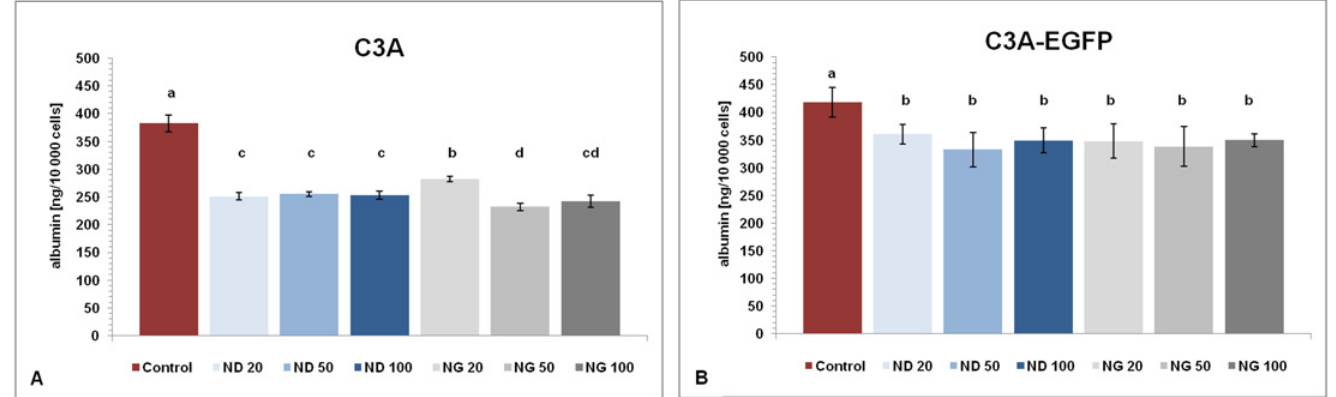
Fig 6. Human serum albumin concentration in culture medium. Albumin secreted by the C3A and C3A-EGFP cells treated for 24 h with the culture medium containing nanoparticles at different concentrations measured by ELISA test: diamond 20 μ g/mL (ND 20), 50 μ g/mL (ND 50) and 100 μ g/mL (ND 100), and graphite 20 μ g/mL (NG 20), 50 μ g/mL (NG 50) and 100 μ g/mL (NG 100). Albumin secretion by cells after 24 h exposure to the medium with different concentrations of diamond and graphite nanoparticles: ( A ) C3A cells and ( B ) C3A-EGFP cells. Nontreated cells were used as a control (Control). Data were analyzed using a two-way ANOVA with the Duncan ’ s test. Data were averaged from three replicates (n = 3); P < 0.05. No significant interaction (nanoparticles with transduction) was observed.